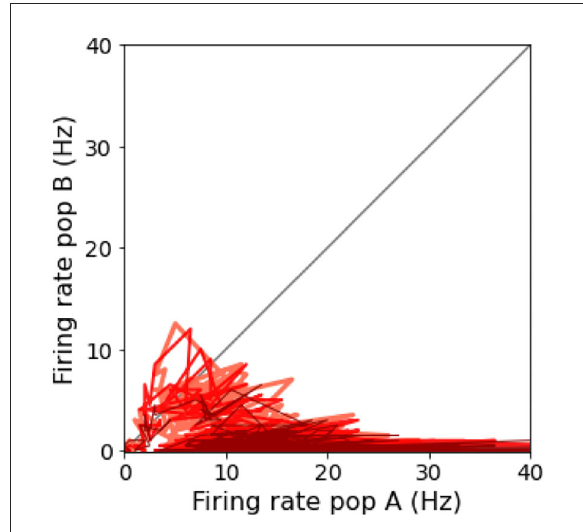
FIGURE4 Decision space: Decision space representation of the three trials report in Figure 3. Darker lines represent a higher level of coherence: light red, 0.0%; red, 12.8%; and dark red, 51.2%.